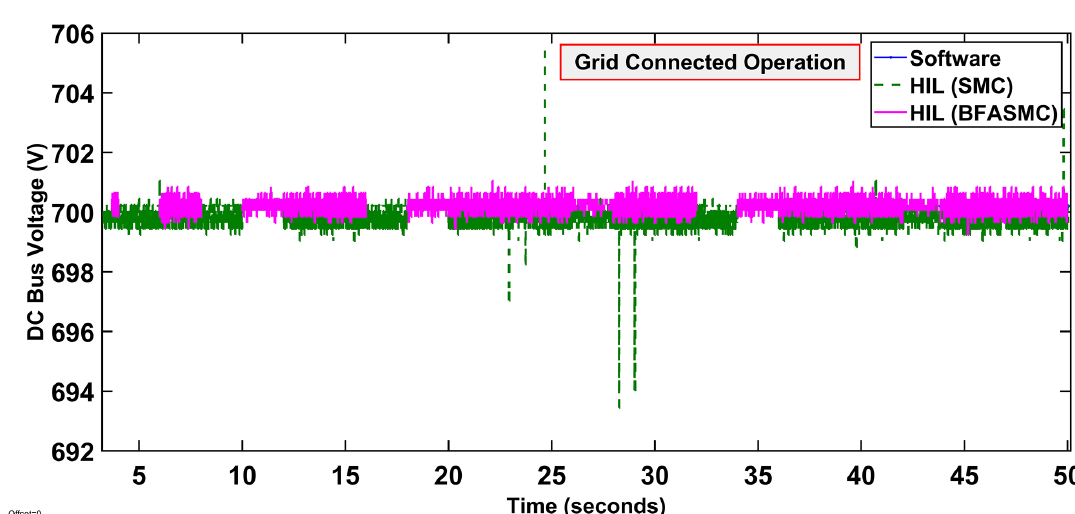
Figure 22. DC bus voltage during grid-connected mode.